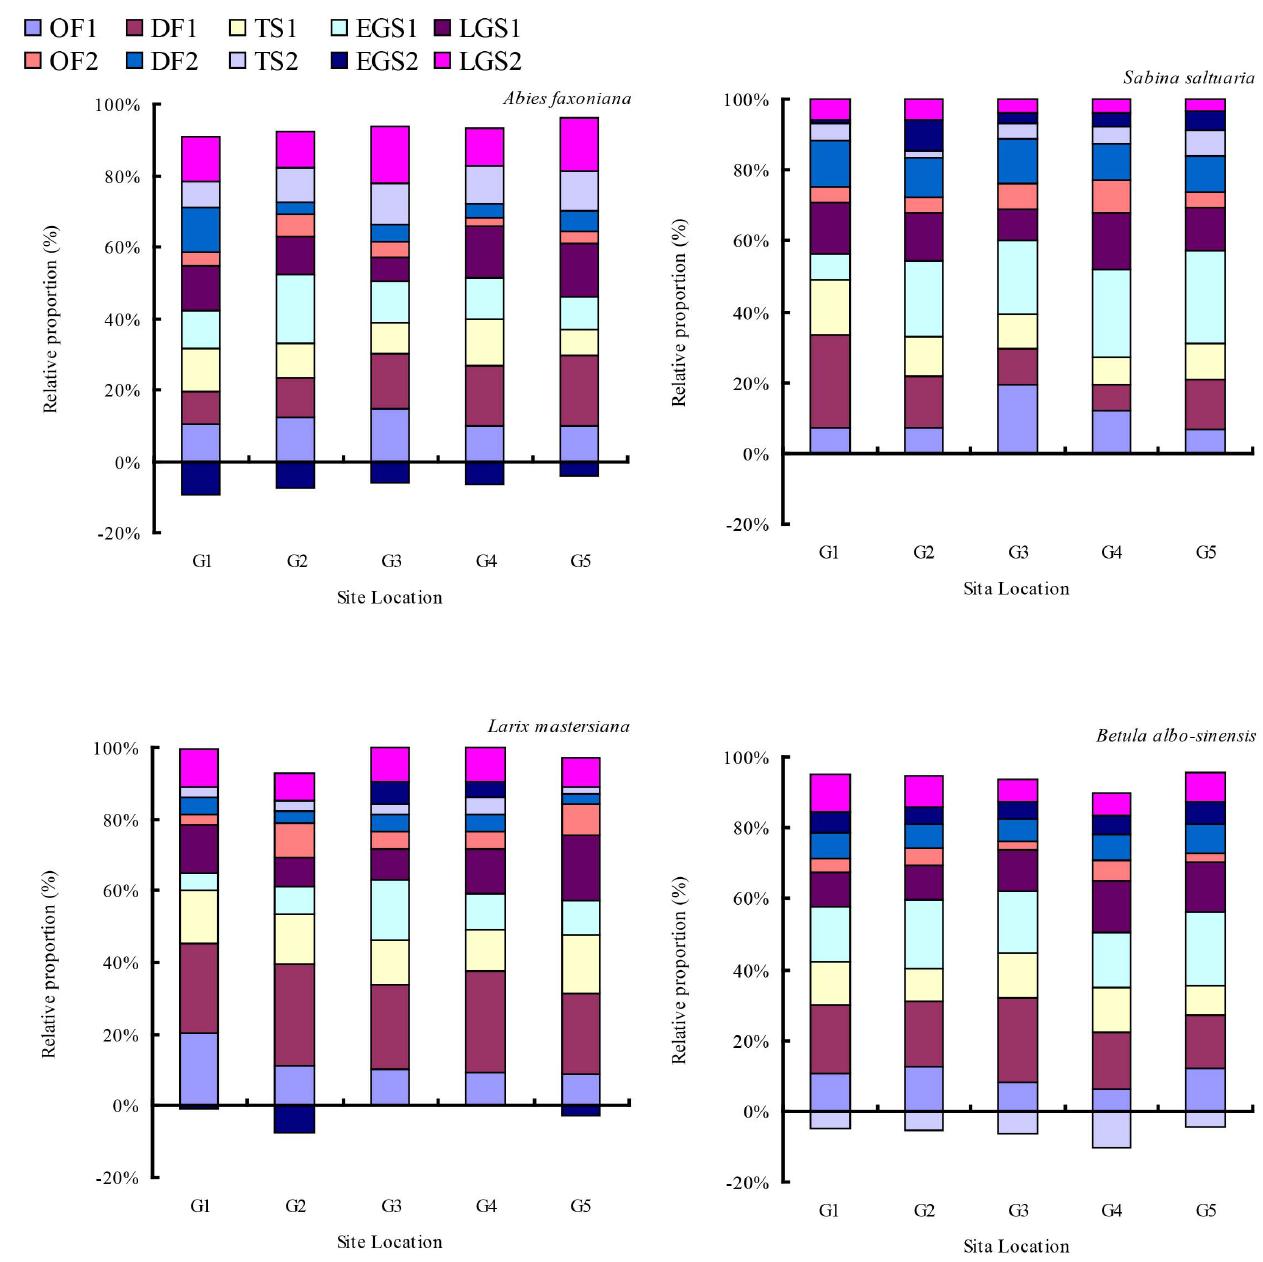
Figure 7. Relative proportion (%) at each decomposition stage to 2 years N release in different gaps. Abbreviations: OF=onset of freezing stage; DF=deep freezing stage; TS=thawing stage; EGS=early growing season; LGS=late growing season; G1=gap 1, gap center south; G2=gap 2, gap center north; G3=gap 3, canopy edge; G4=gap 4, expanded edge; G5=gap 5, closed canopy.